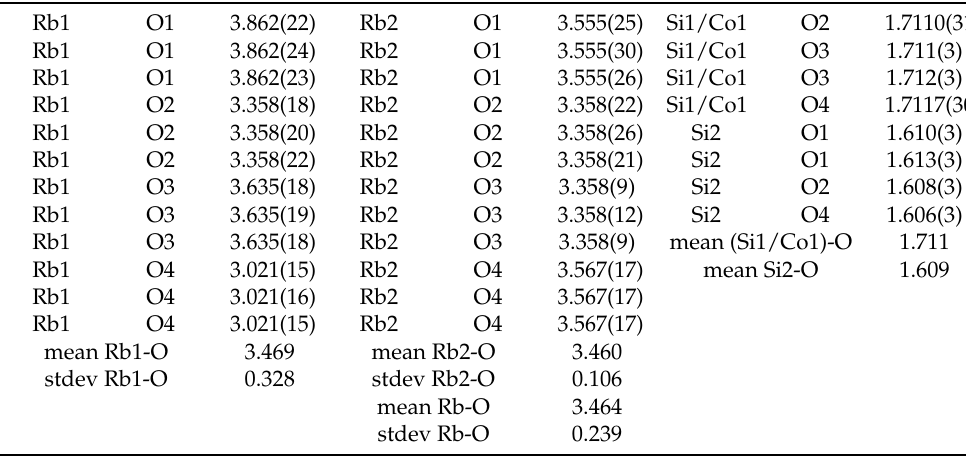
Figure 11. VESTA plot showing the 1133 K (MgO calibrated temperature) Pa 3 cubic crystal structure of Rb 2 CoSi 5 O l2 . Pink spheres represent Rb + cations, red spheres represent O 2 − anions, dark blue tetrahedra represent SiO 4 units and light blue tetrahedra represent (Si 2/3 Co 1/3 )O 4 units. Table 5. Refined atomic coordinates for 1133 K Rb 2 CoSi 5 O l2 . Table 6. Refined interatomic distances (Å) for 1133 K Rb 2 CoSi 5 O l2